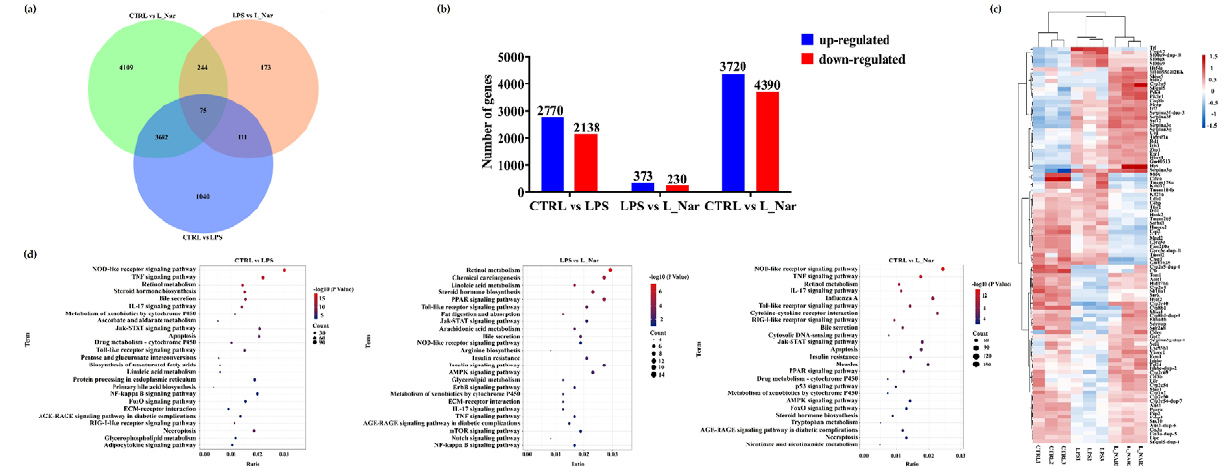
Figure 4. Effects of naringenin on the liver mRNA of mice: ( a ) Venn diagram analysis of co-expressed genes derived from RNA sequencing; ( b ) number of significantly upregulated and downregulated genes in comparisons of the CTRL and LPS groups, LPS and L_Nar groups, and CTRL and L_Nar groups; ( c ) hierarchical clustering of the liver samples and the expression pattern of DEmRNAs based on the transcriptomic profiles; ( d ) comparison of the KEGG pathways enriched for upregulated and downregulated genes. Data are expressed as mean ± SEM ( n = 3). * p < 0.05, ** p < 0.01, *** p < 0.001 versus CTRL group. DEmRNA: differential expression mRNA.